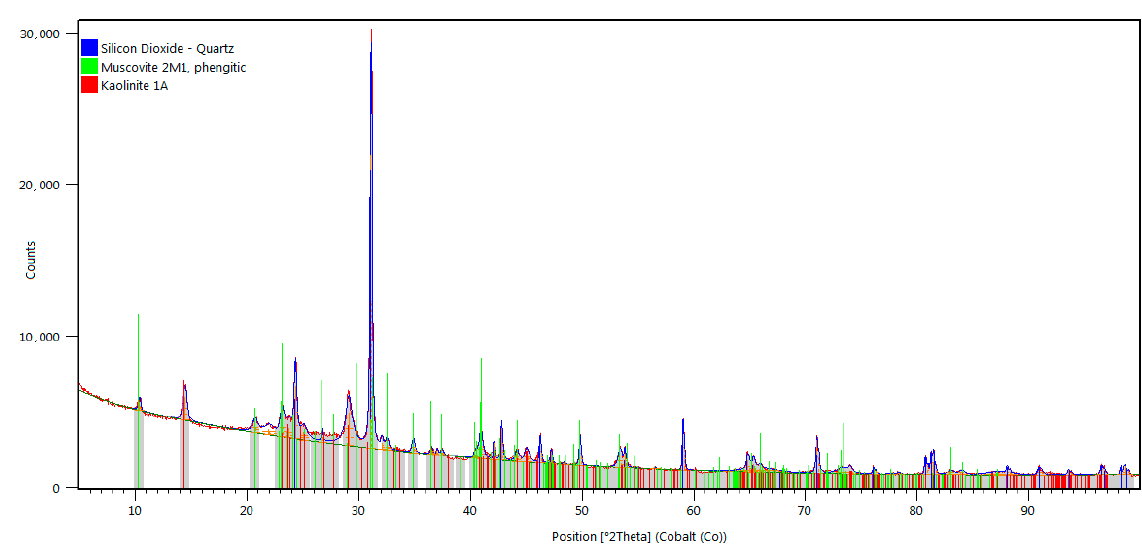
Figure 6. Sample claystone diffractogram.